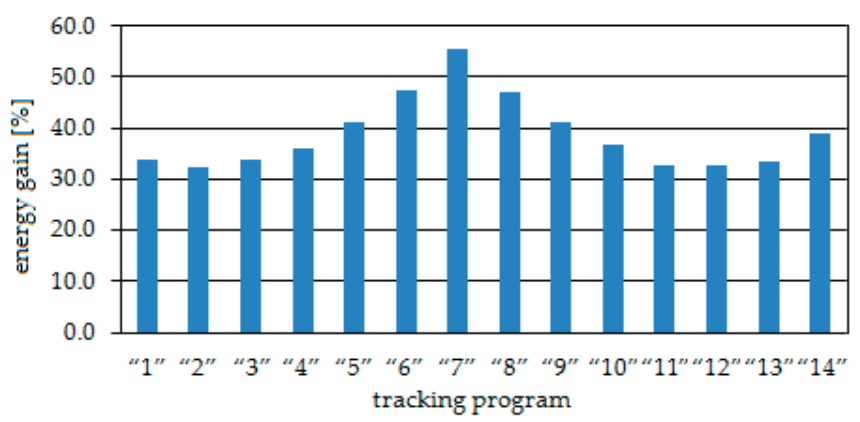
Figure 17. Energy gain provided by the proposed tracking